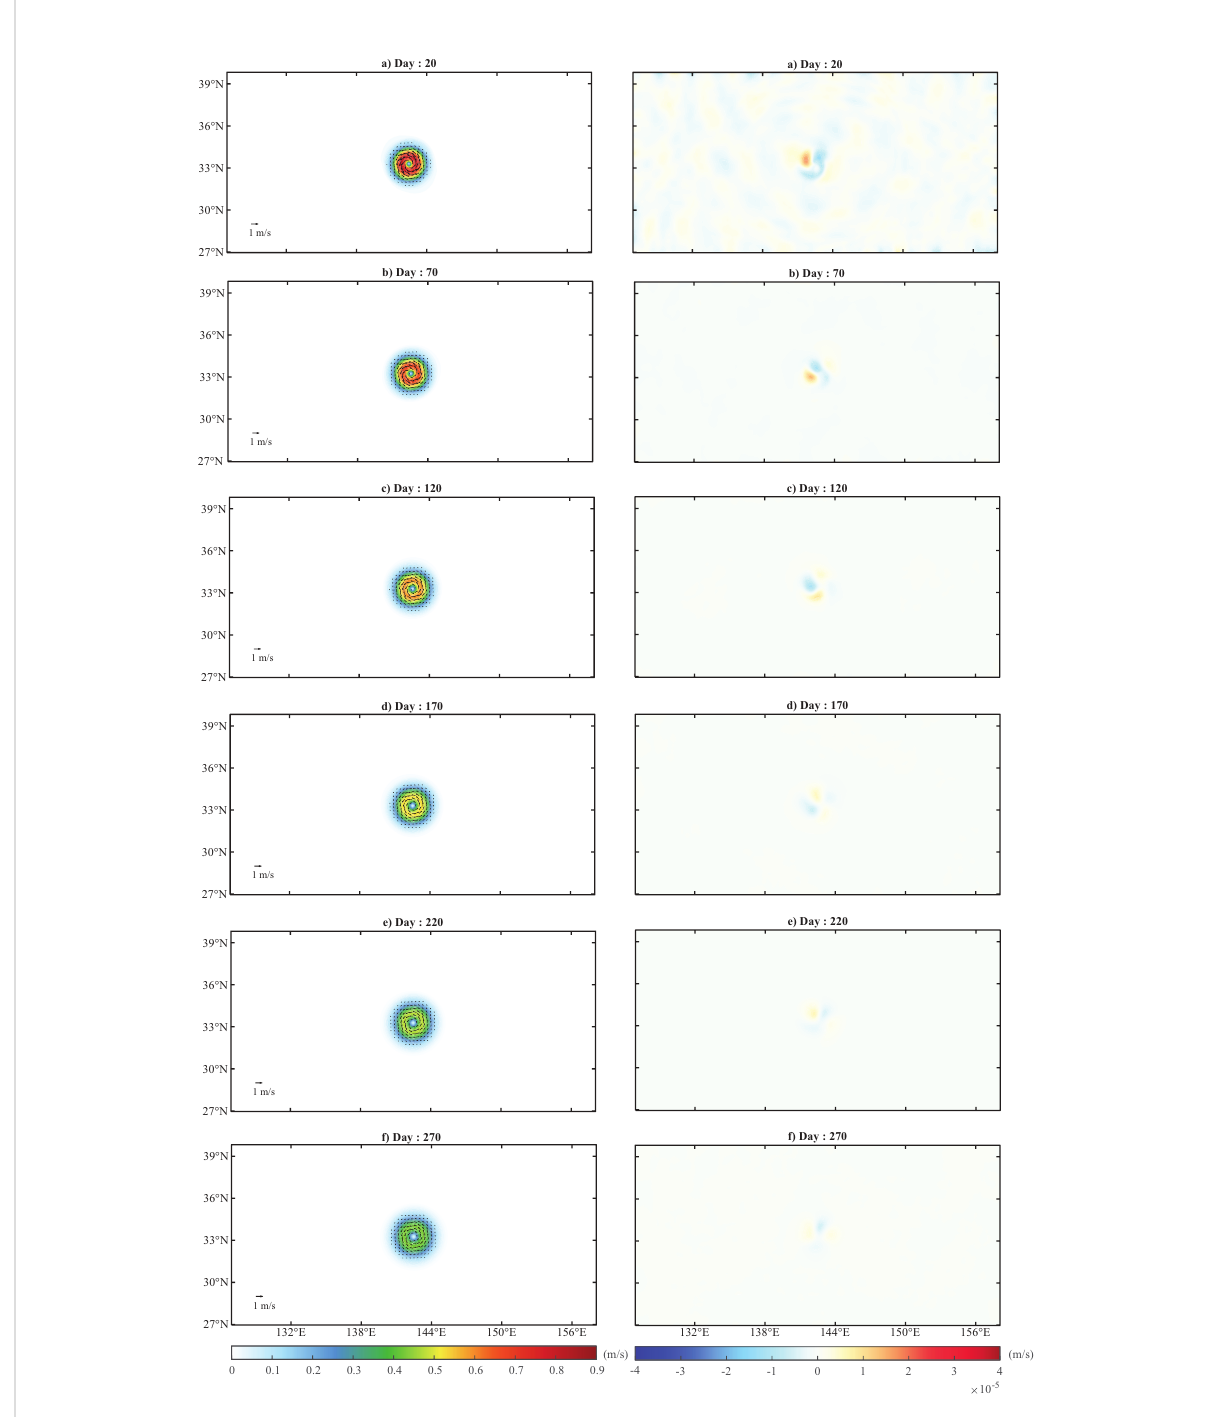
FIGURE 4 Same as Figure 3 except for the idealized eddy on the f